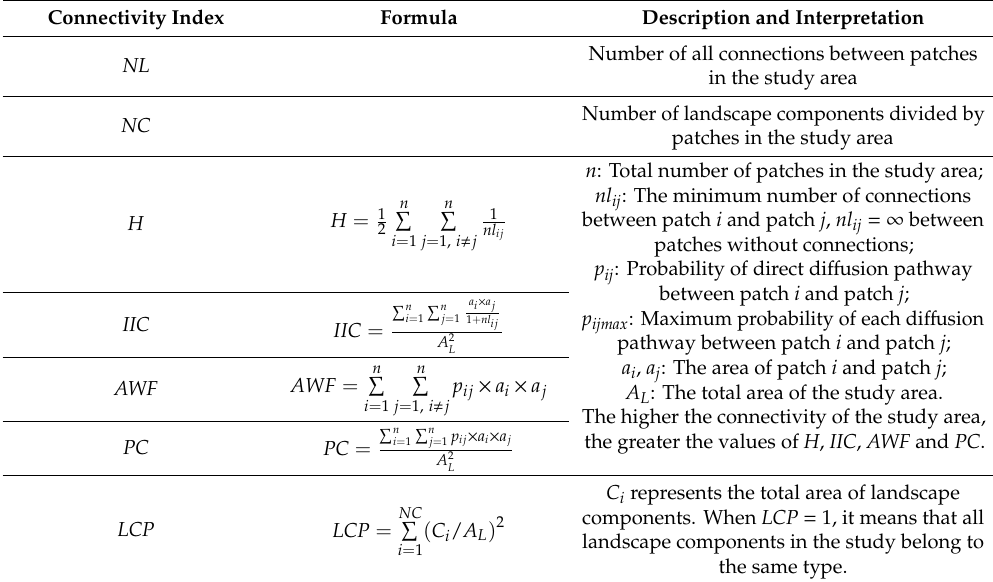
Table 2. Calculation formulas and descriptions of landscape connectivity